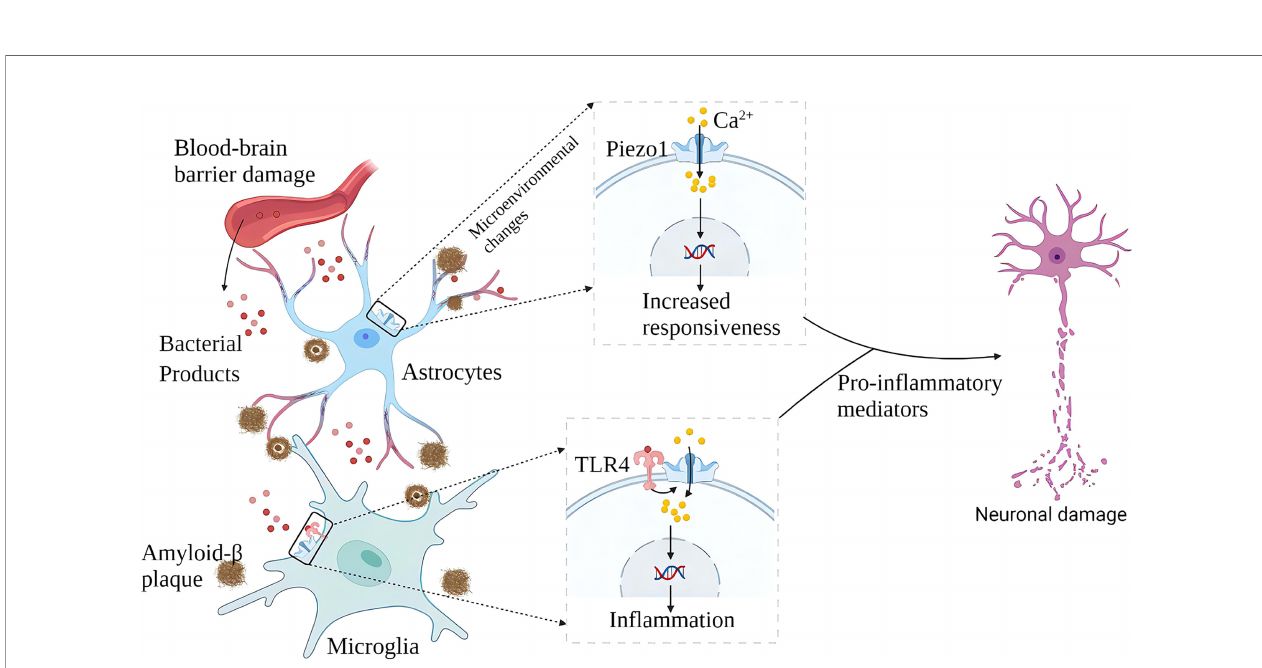
FIGURE 4 | Schematic diagram of the role of Piezo1 in AD. In AD, plaque deposited brain tissue has increased stiffness, increased expression of Piezo1 in astrocytes and microglia exposed to amyloid plaques, and increased in fl ammatory reactivity. Upregulation of Piezo1 in cerebral vascular endothelial cells induced by various mechanical factors damages the vascular endothelium, leading to increased blood-brain barrier permeability and more bacterial products entering the brain. Bacterial products such as LPS activate TLR4 to initiate microglial innate immune responses, and Piezo1 coordinates TLR4 signaling and induces Ca 2+ inward fl ow, regulating cellular immune activity. Chronic in fl ammation and neuronal damage lead to cognitive impairment.